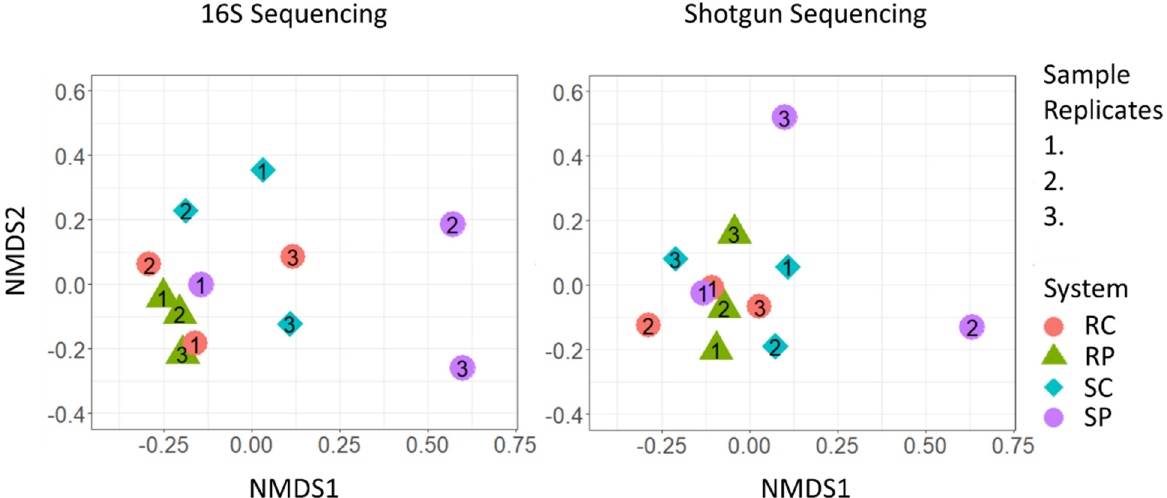
Figure 4. Non-metric dimensional scaling ordination plots of Bray–Curtis dissimilarity matrices of on-site wastewater treatment system microbial communities that were examined using 16S and shotgun sequencing. Procrustes analysis of the ordination points produced a sum of squares of 0.0982 and a Procrustes correlation of 0.950.